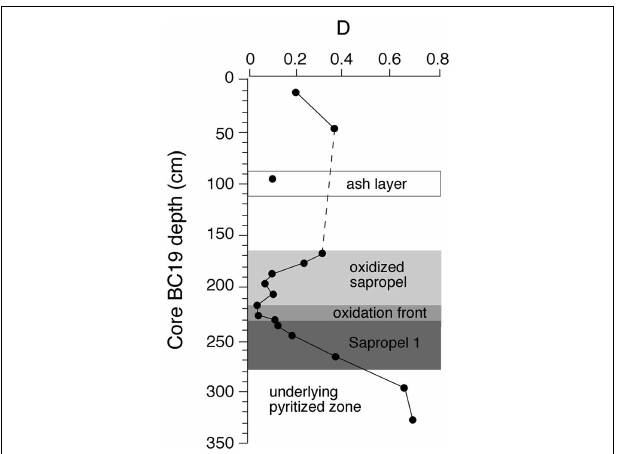
FIGURE 5 | Variations of D (which indicates the degree of maghemitization based on the divergence of the zero-field-cooled and field-cooled remanent magnetization curves above the Verwey transition) vs. depth for core BC19. Redrawn after Passier and Dekkers